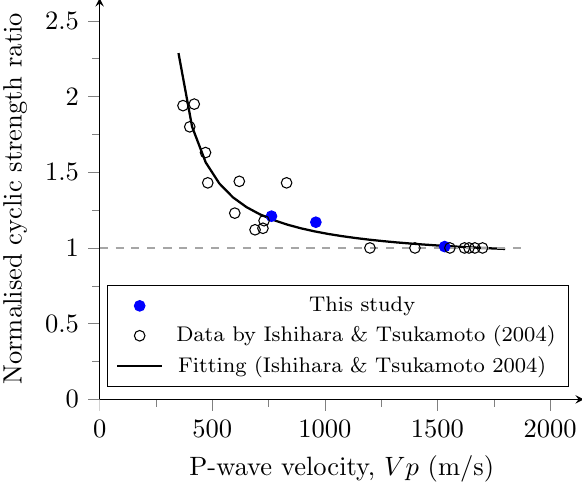
Figure 10. Normalised cyclic strength ratio as a function of Vp